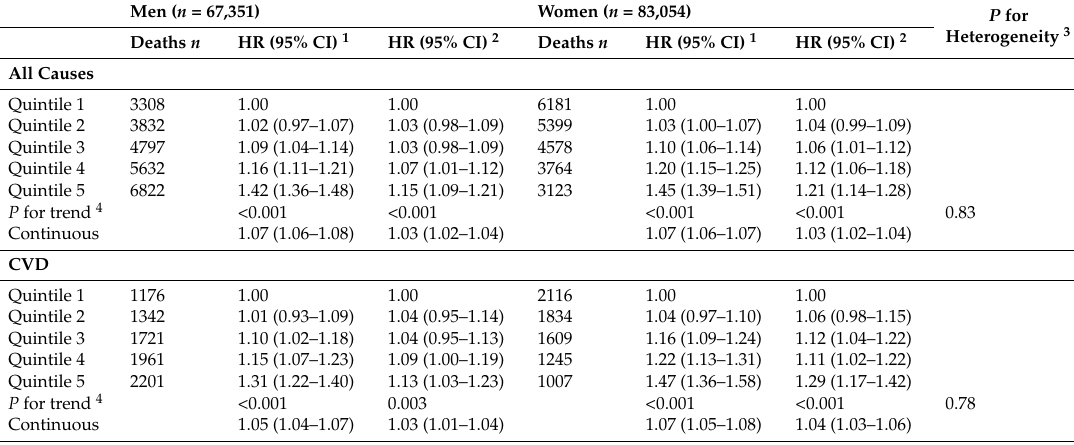
Table 2. Hazard ratios (HR) (95% confidence intervals (CI)) for all-causes, cardiovascular disease (CVD), and cancer mortality according to quintiles of Dietary Inflammatory Index scores in the Multiethnic Cohort,